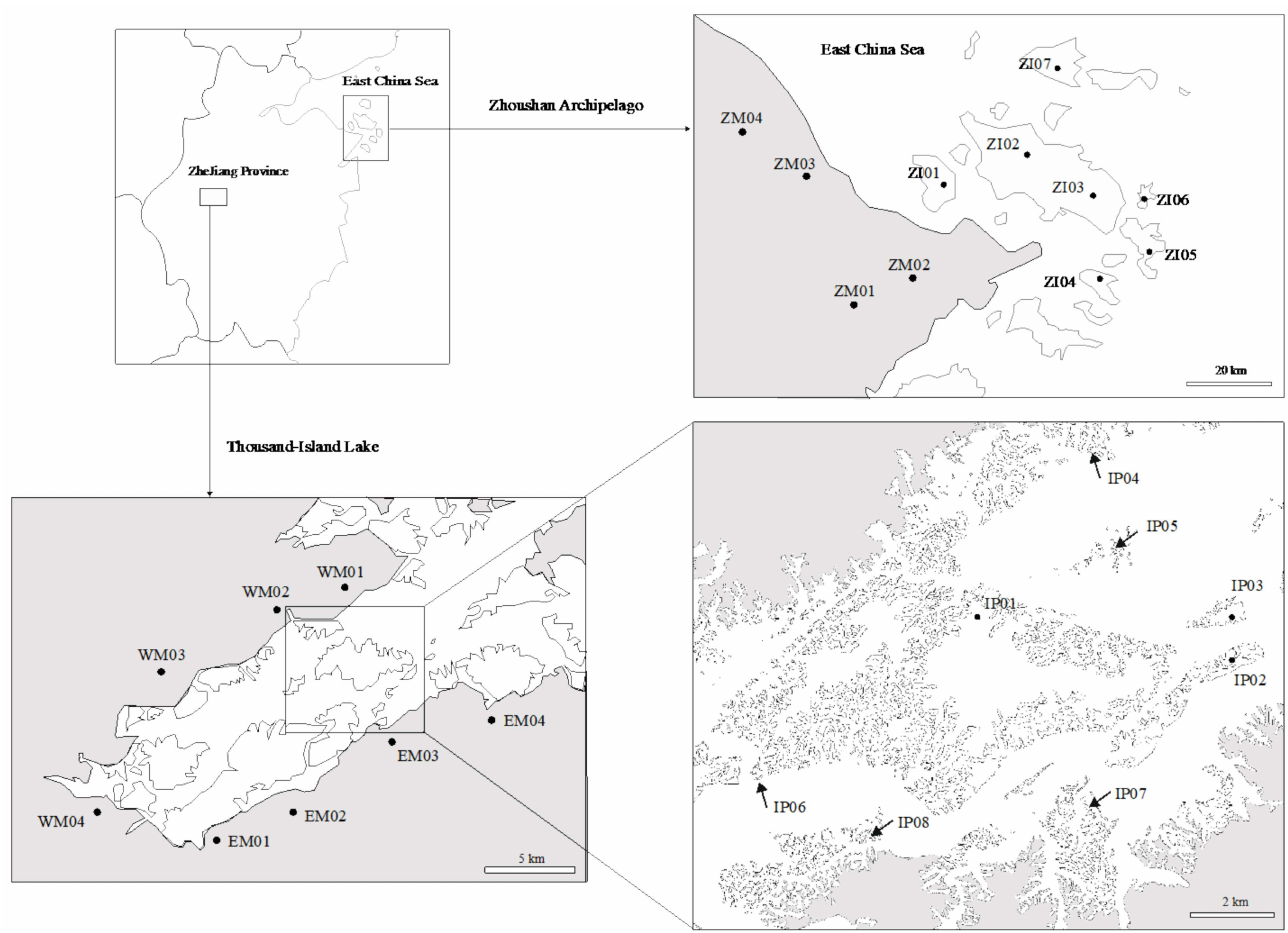
Figure 5. Sample localities of Hedyotis chrysotricha in the Thousand-Island Lake (TIL) region and the Zhoushan Archipelago (ZA) region of southeast China. Population codes are identified in Tables 1 and